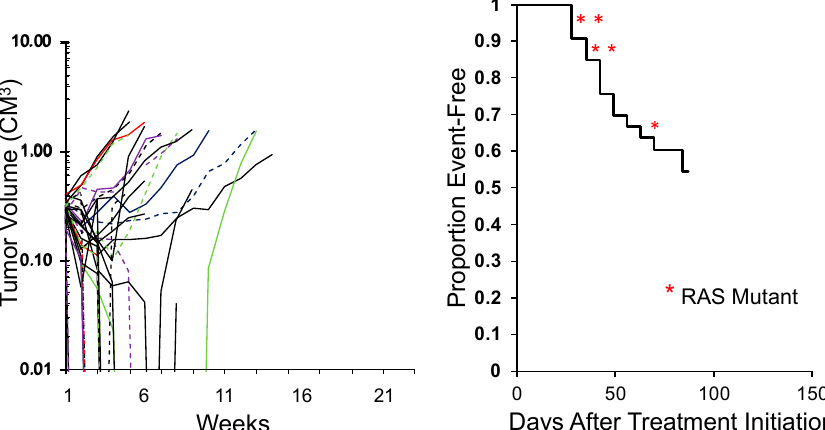
Figure 4. Left : Initial responses of 34 RMS models to Cycle 1 vincristine + actinomycin D + cyclophosphamide (VAC) using the SMT experimental design (ongoing expt.). Right : Kaplan–Meier plot for EFS. Red asterisks: RAS mutant ERMS models.